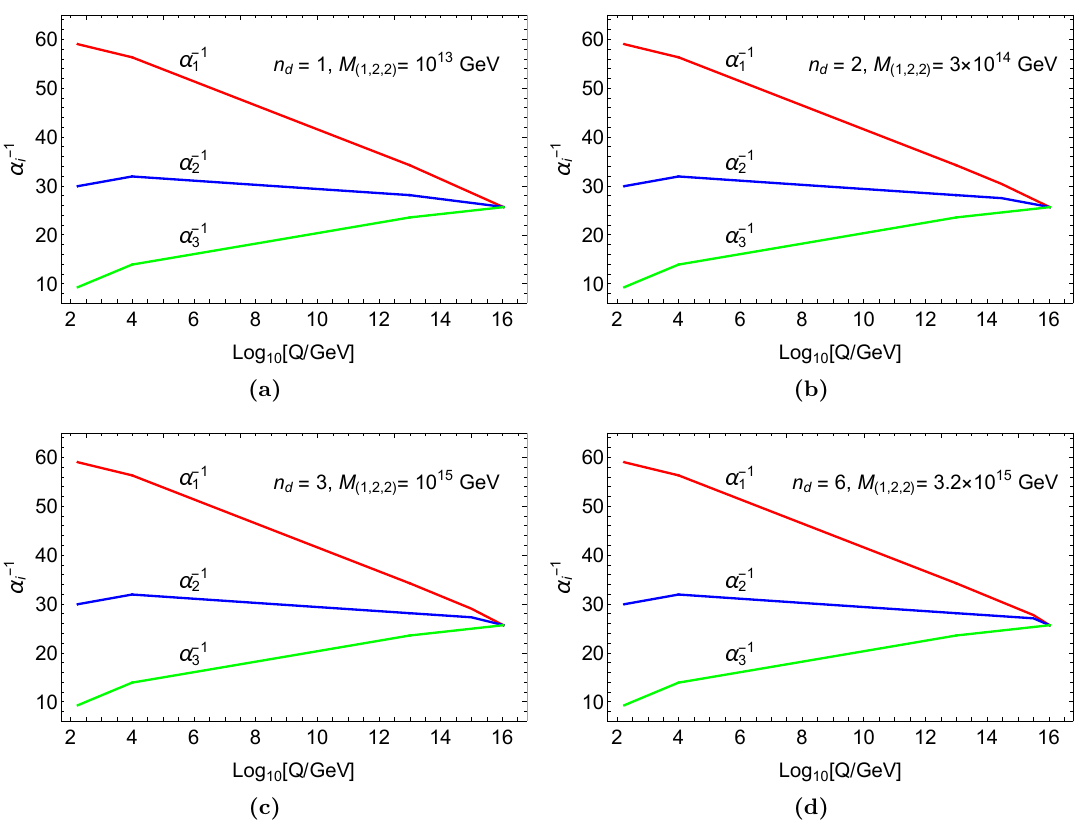
Figure 7. The evolution of the inverse gauge couplings (cid:11) (cid:0) 1 the R -symmetric G 4-2-2 model where the two color-triplet (cid:12)elds d c of intermediate mass (cid:24) 10 13 GeV, appropriate for potentially observable proton decay. The gauge- coupling uni(cid:12)cation is shown for four choices with n d = 1 ; 2 ; 3 ; 6 number of additional bi-doublets of mass M = 10 13 ; 3 (cid:2) 10 14 ; 10 15 ; 3 : 2 (cid:2) 10 15 GeV, (1 ; 2 ; 2)